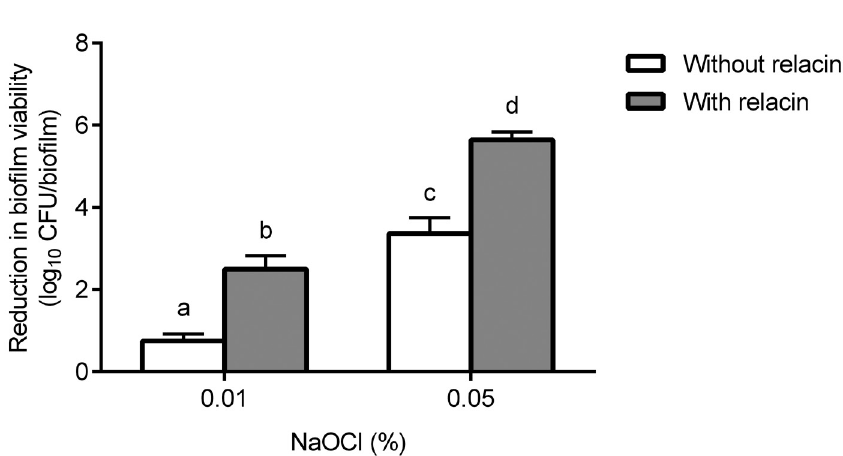
Figure 2- Treatment efficacy of NaOCl alone or in combination with relacin. The 48-h E. faecalis OG1RF biofilms were treated by NaOCl alone (white bar) or pretreated by 14 mM relacin for 24 h (gray bar). The efficacy of each treatment is presented as the reduction in biofilm viability. Different lowercase letters indicate significant difference